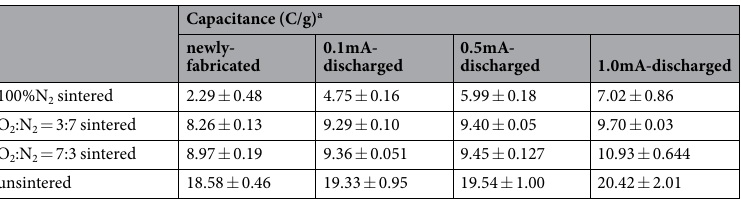
Table 1. Equivalent electron capacity of BC-based electrodes with different pre-treatments (‘0.1mA-discharged’, ‘0.5mA-discharged’, ‘1mA-discharged’ represent charged electrodes discharged with 0.1, 0.5 and 1.0 mA constant current, respectively). a Shown are average values calculated from measurements of replicate BC-based electrodes (shown in Fig. 4 and Fig. S10) ± standard deviations.